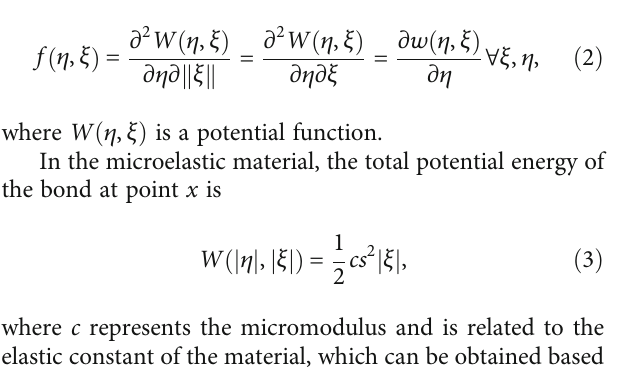
Figure 5: The convergence of the force under di ff erent loading